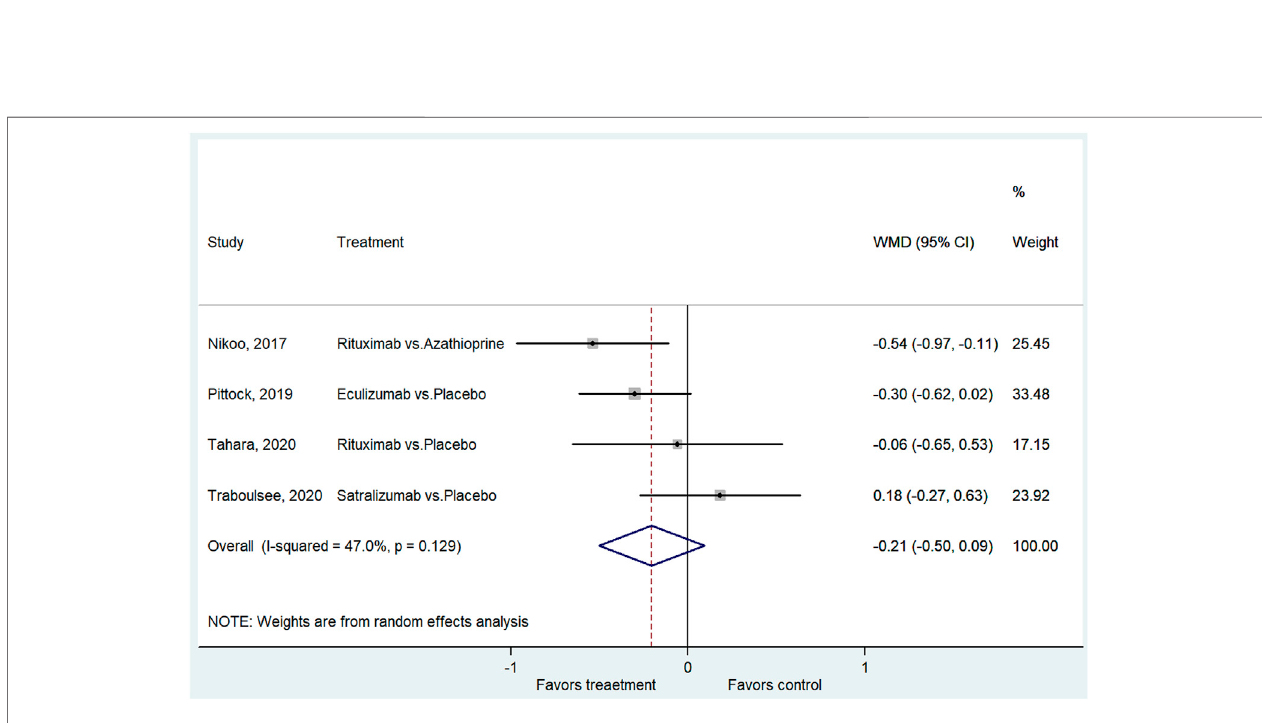
FIGURE 4 | Forest plot of EDSS score change from baseline.